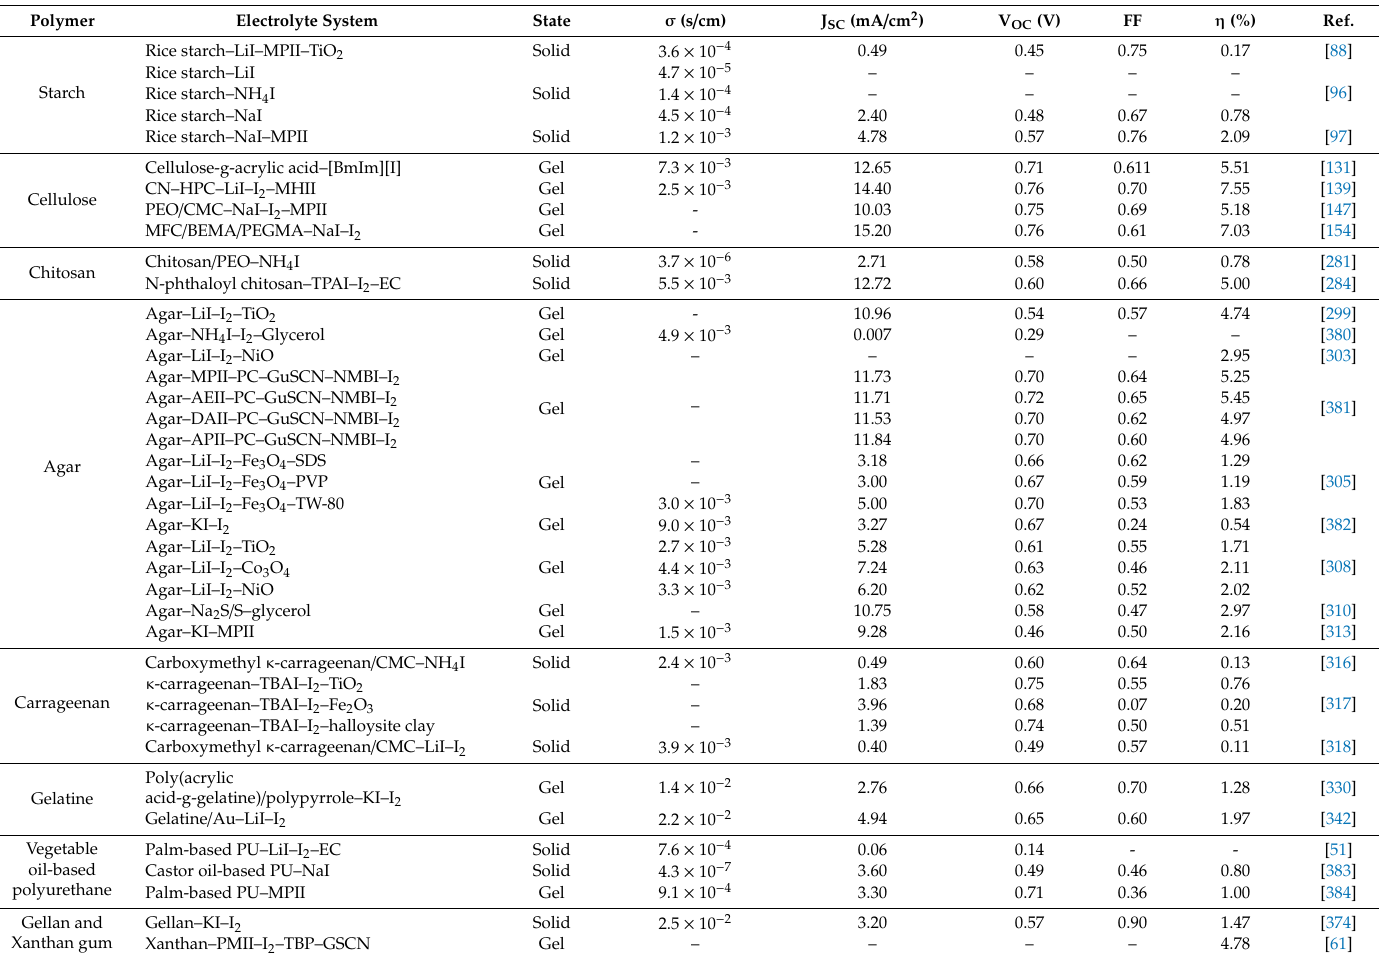
Table 4. The photovoltaic performance of DSSC observed in bio-based polymers–salt matrix.